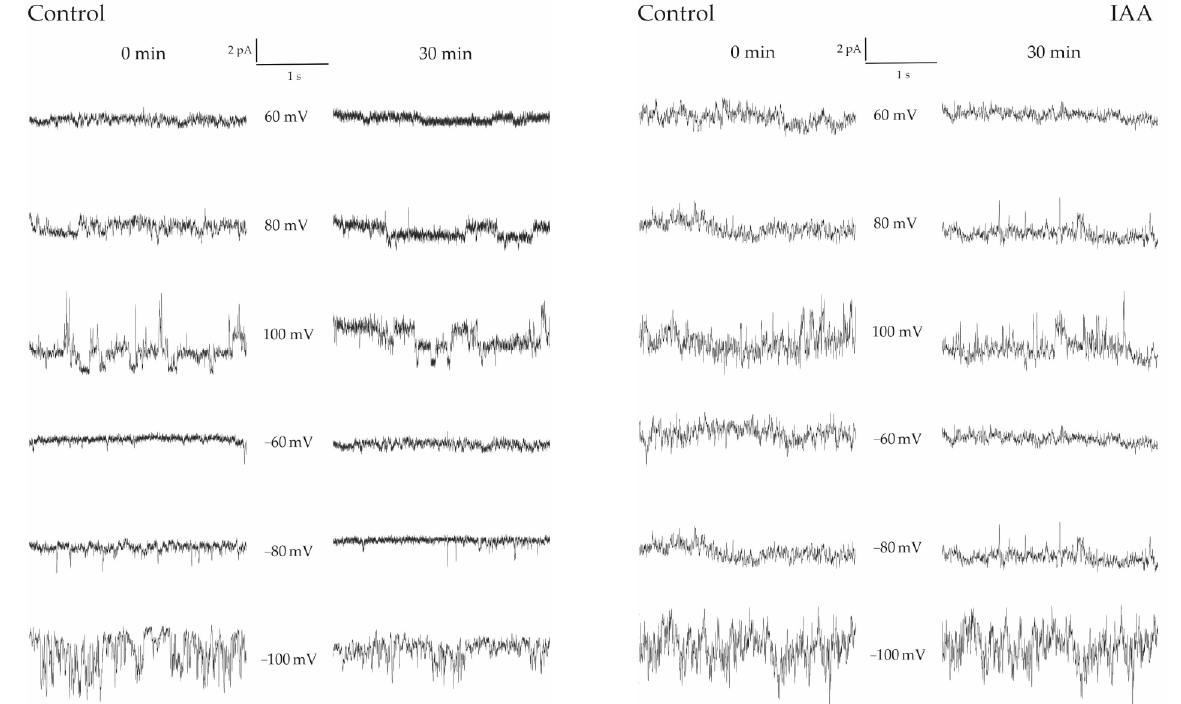
Figure 4. Examples of fast-activating currents in excised vacuolar side-out membrane patches incubated in the control medium and in the presence of auxin (IAA). The currents were measured at symmetrical 100 mM KCl. On the left-hand side, the control at 0 min and 30 min with the same patch is shown. However, on the right-hand side, the control at 0 min and in the presence of auxin (30 min) with the same patch is shown.